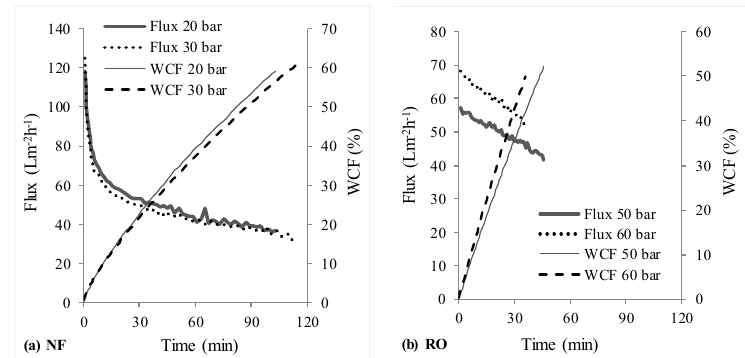
Figure 3. Measured permeate flux and WCF-NF followed by RO (scheme 1, NF → RO).